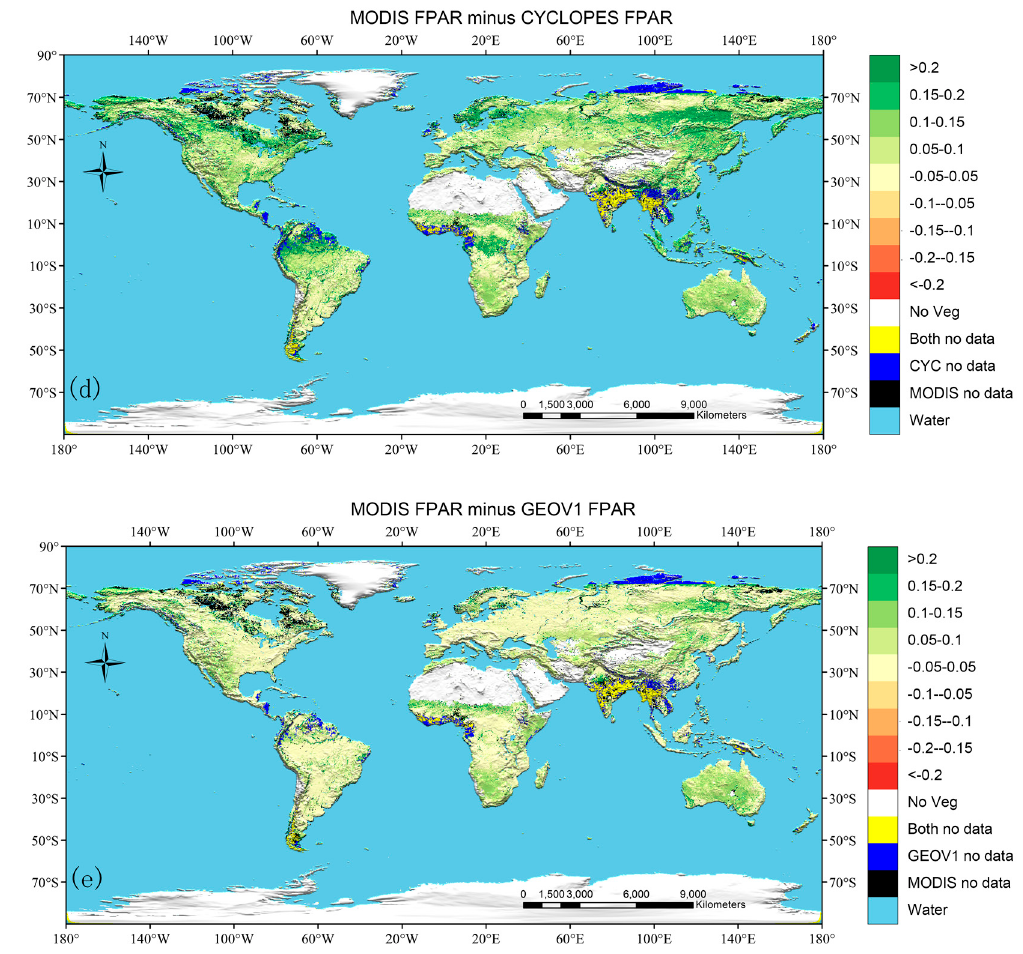
Figure 3. Global distribution of absolute differences between ( a ) MODIS and GLASS LAI; ( b ) MODIS and CYCLOPES LAI; ( c ) MODIS and GEOV1 LAI; ( d ) MODIS and CYCLOPES FPAR; and ( e ) MODIS and GEOV1 FPAR in July 2001. The spatial resolution is 0.25 degrees. MODIS is found to agree best with GLASS, as expected, with absolute differences within ±0.5 LAI units for most of the land surface (Figure 3a). The reasons are two-fold: (1) the surface reflectance data input to the two algorithms are from the same MODIS instrument; (2) MODIS LAI products are used as one part of the ANN training data for GLASS. Compared to GLASS, most